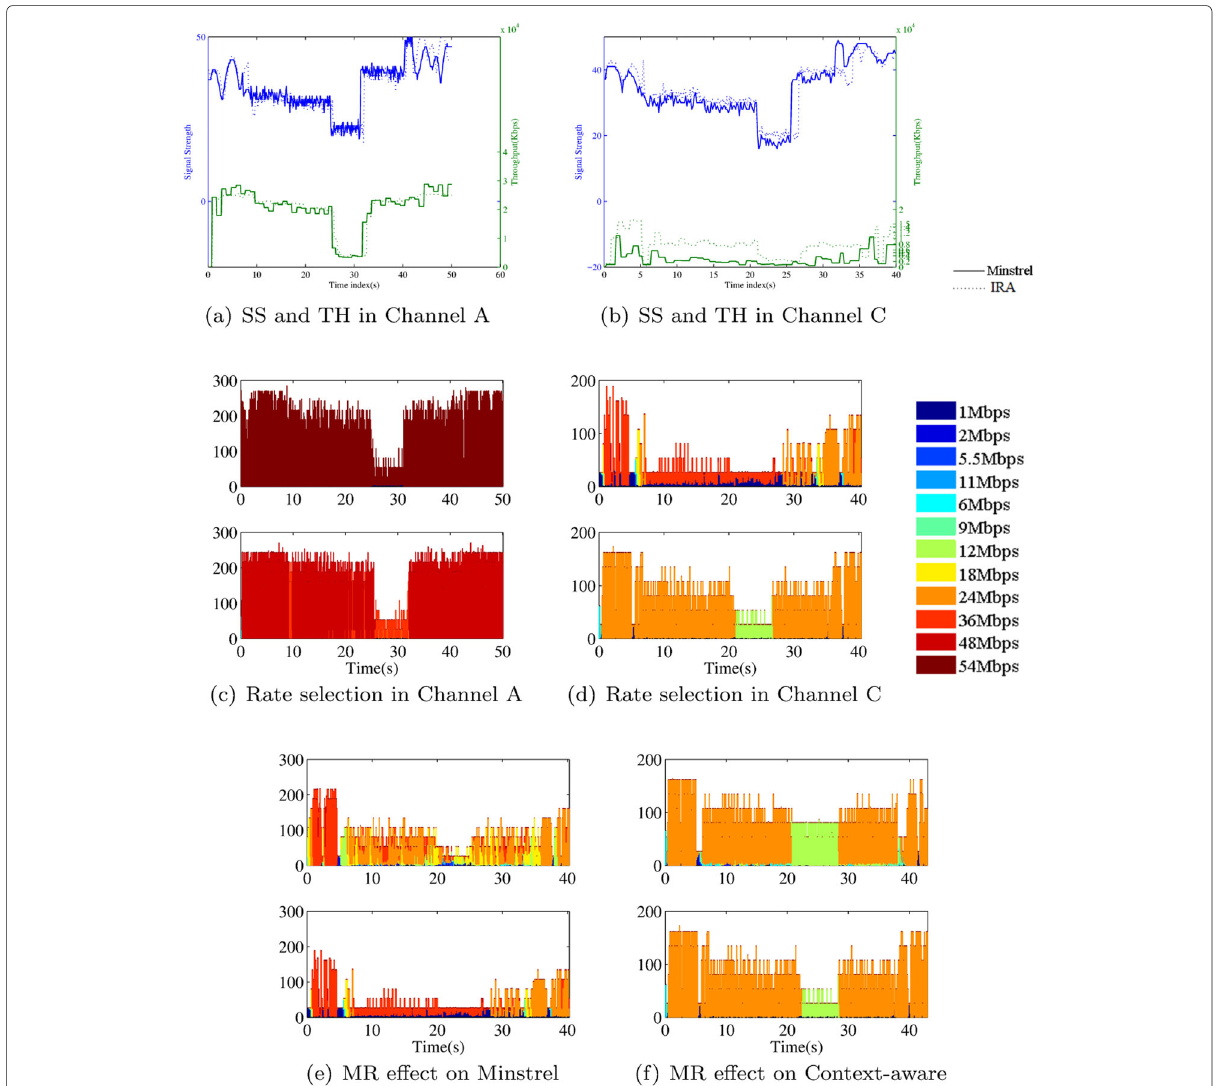
Fig. 5 Signal strength (SS), throughput (TH), and rate selection comparison on emulated channels. Rate selection behavior varies with the signal strength and the multi-rate setting. c , d The top is Minstrel, and the bottom is context-aware. e , f The top is with MR, and the bottom is without MR